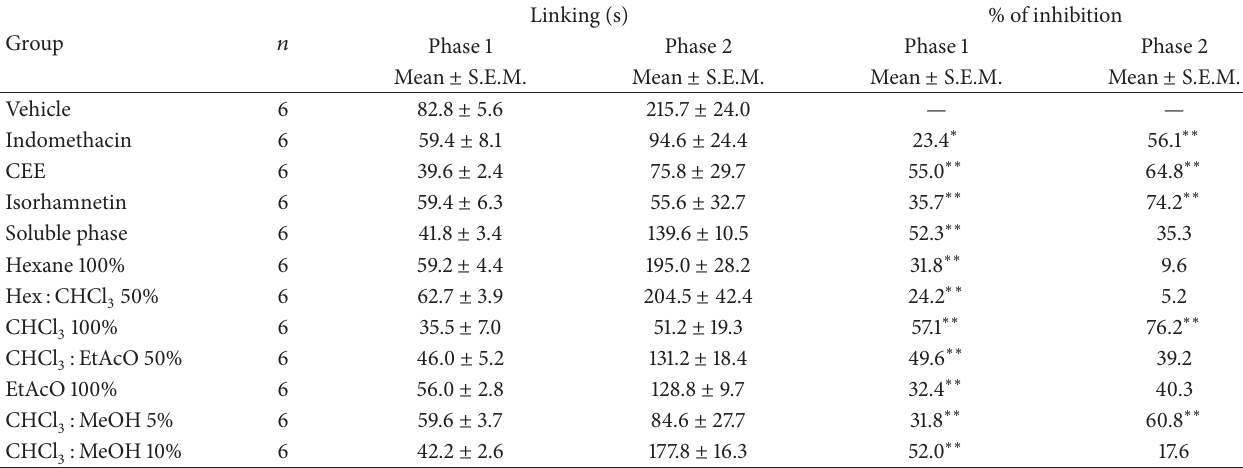
Table 4: Effects of extract, fractions (100mg/kg, p.o.), isorhamnetin, and indomethacin (100 𝜇 mol/kg, p.o.) in nociception induced by formalin.